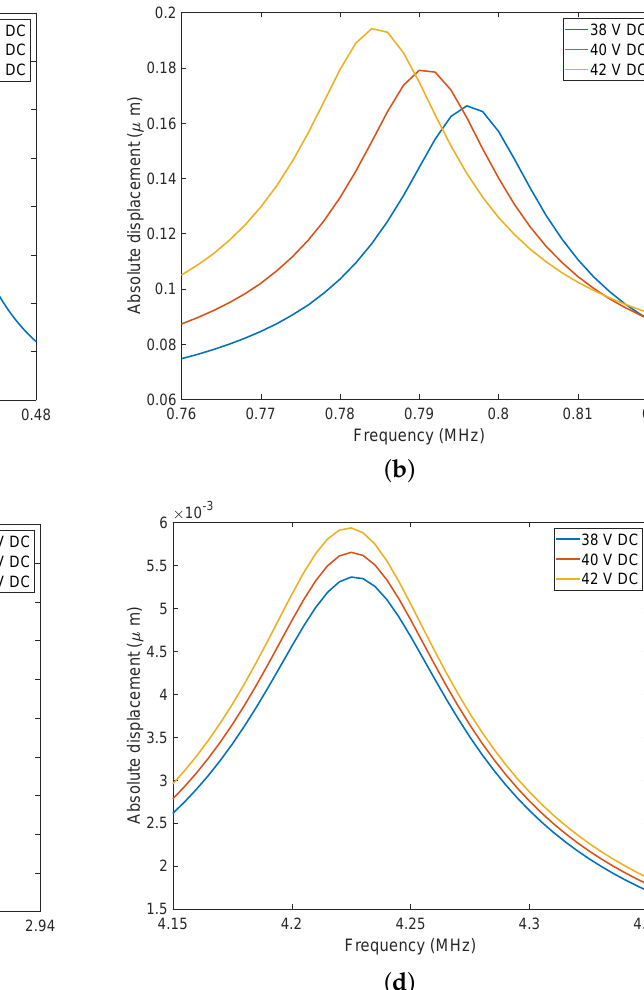
Figure 12. Peak-to-peak amplitude of CMUTs. ( a ) Peak-to-peak amplitude of CMUT A; ( b ) peak-to- peak amplitude of CMUT B; ( c ) peak-to-peak amplitude of CMUT C; ( d ) peak-to-peak amplitude of CMUT D.